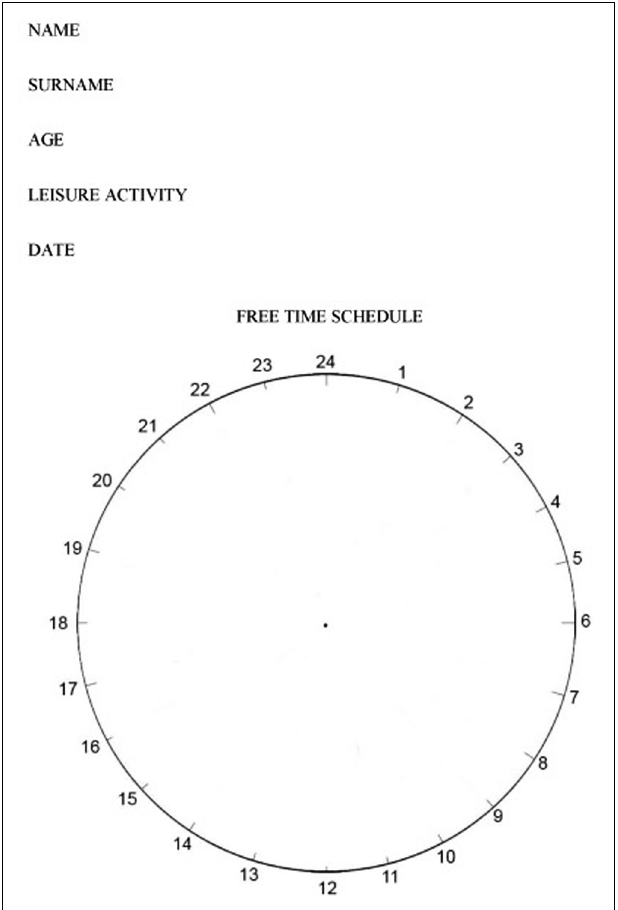
FIGURE 1 |Test of the organization of free time